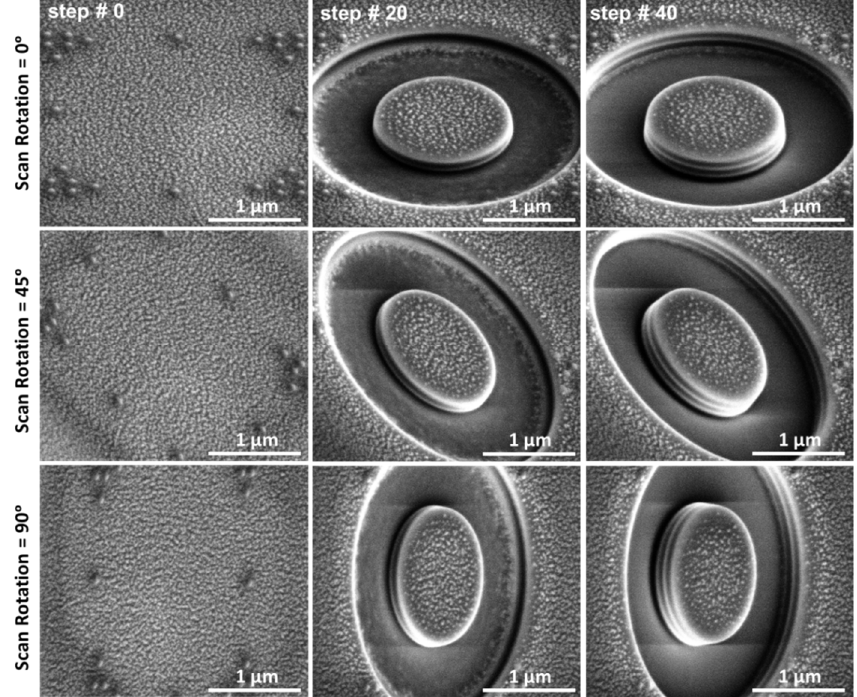
Figure 5. Step-by-step FIB milling of a 1.5 µm pillar on the coating. Surface features are gold patterning to facilitate the DIC procedure. The different layers are visible in the micrographs.